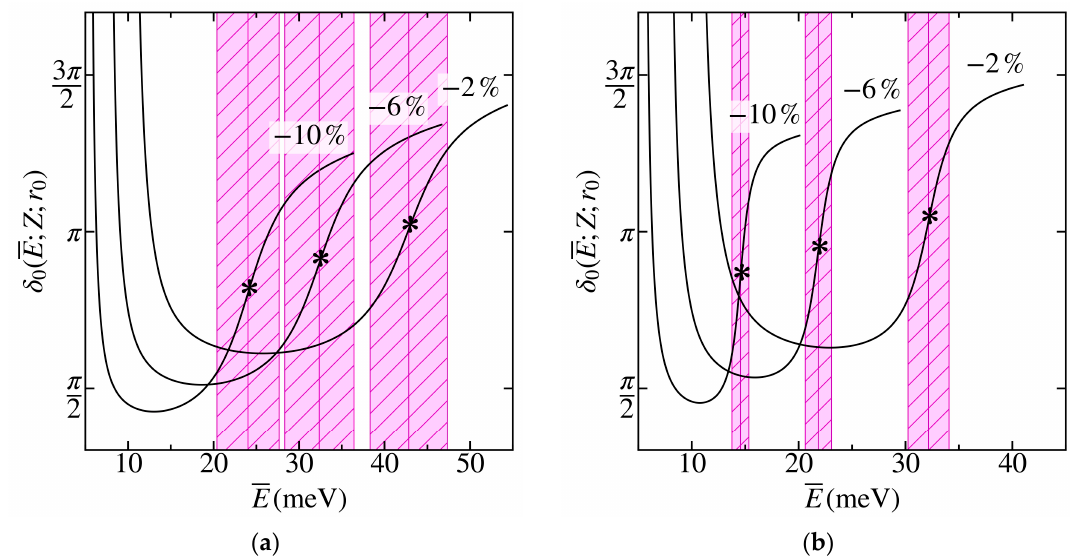
Figure 8. The scattering phase δ 0 ( E ; Z ; r 0 ) as a function of the hole energy E in states with the total angular momentum J = 0 for graphene on the h BN substrate. The impurity charge Z = 1, the cutoff radius r 0 = 15Å, and the cutoff function corresponds to the uniform charge distribution over the sphere of the radius r 0 ( a ) and over the ball of the same radius ( b ). The asterisks mark positions of the resonances E ∗ corresponding to the quasi-stationary states with n = 2 ( a ) and n = 3 ( b ), the shaded areas mark their widths Γ ∗ . The numbers indicate the compression values σ